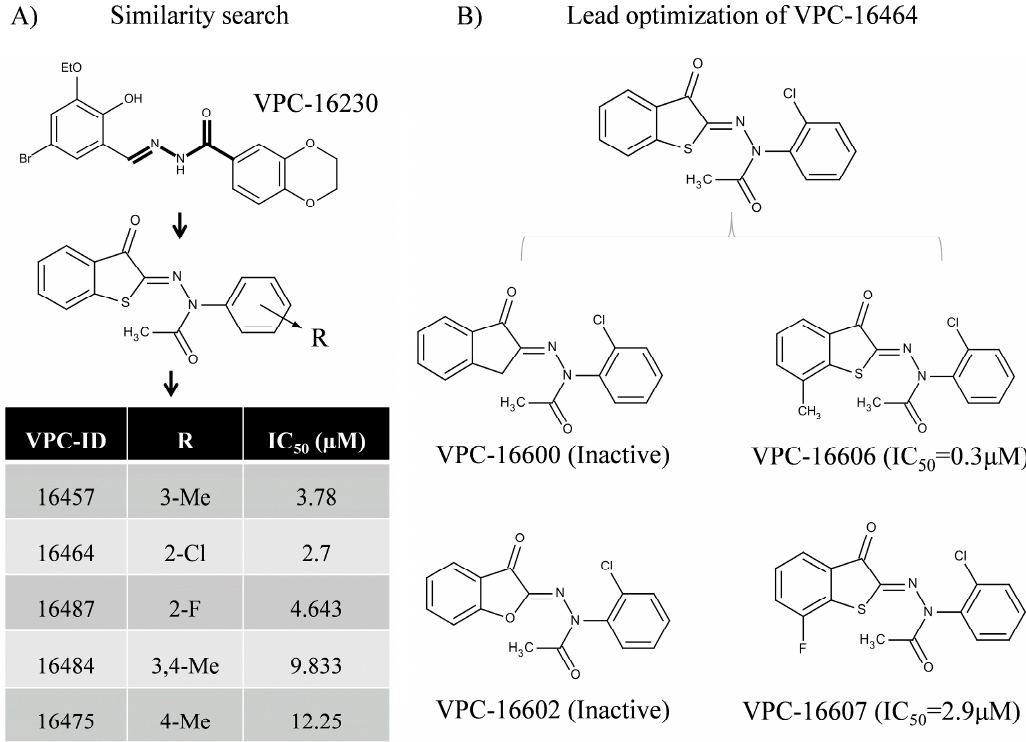
Figure 1. Identification and structure-guided lead optimization of benzothiophenone derivatives. ( A ) Previously-reported compound VPC-16230 (half maximal inhibitory concentration (IC 50 ) 5.8 µM)